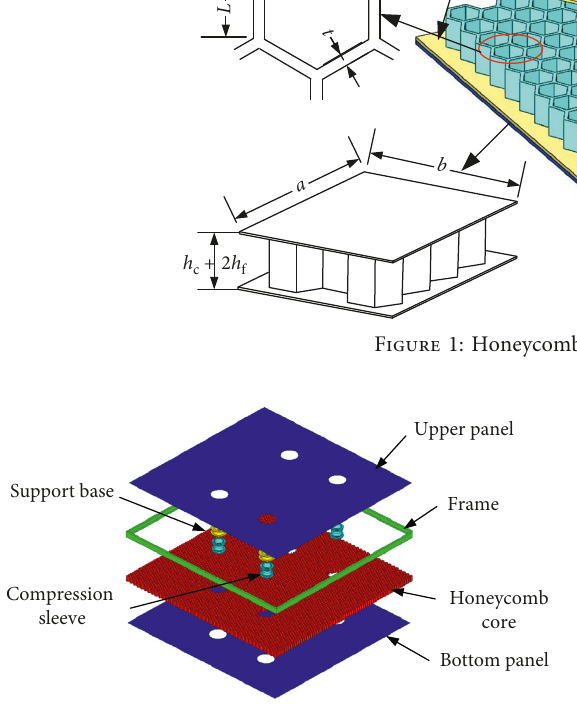
Figure 2: Expanded diagram of finite element model of sailboard. Table 1: Unit type and material properties of each part of the sailboard finite element